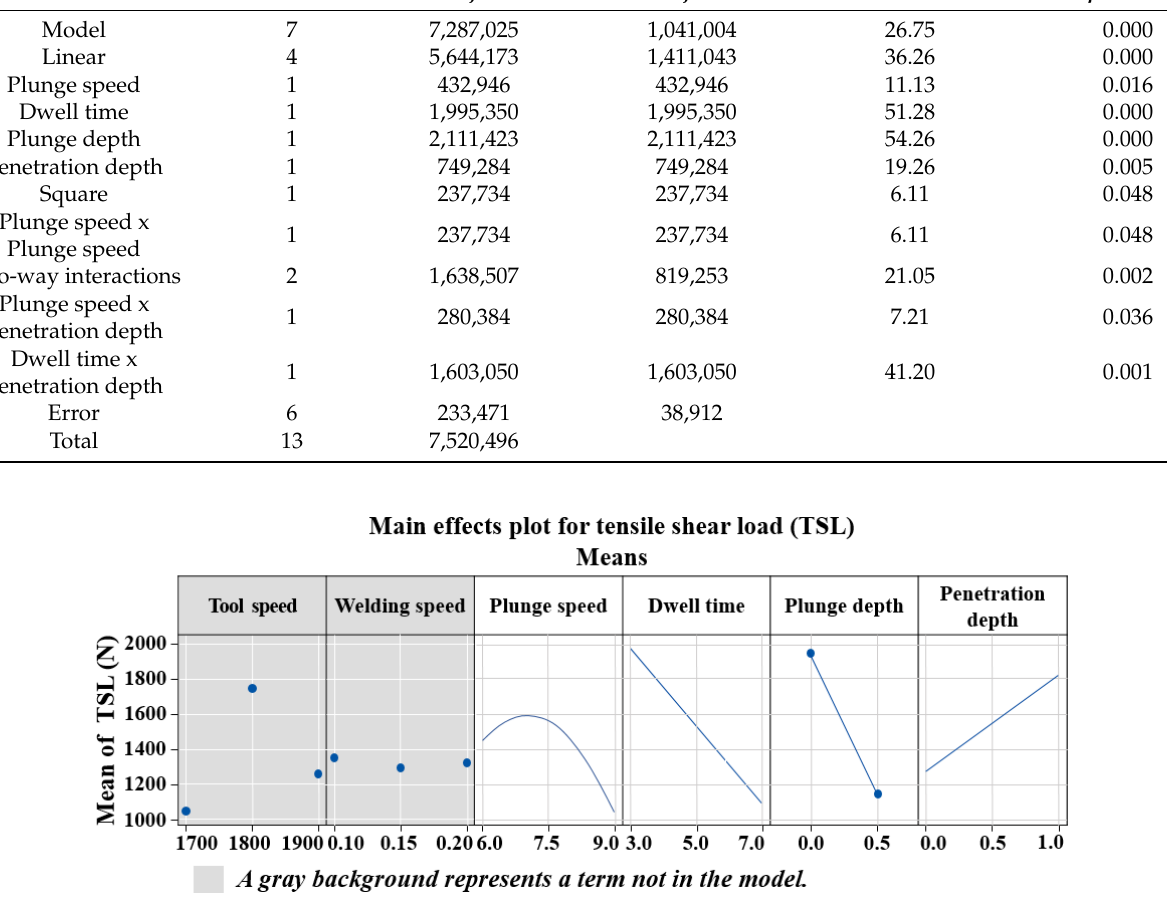
Figure 3. Main effect plots for tensile shear load.